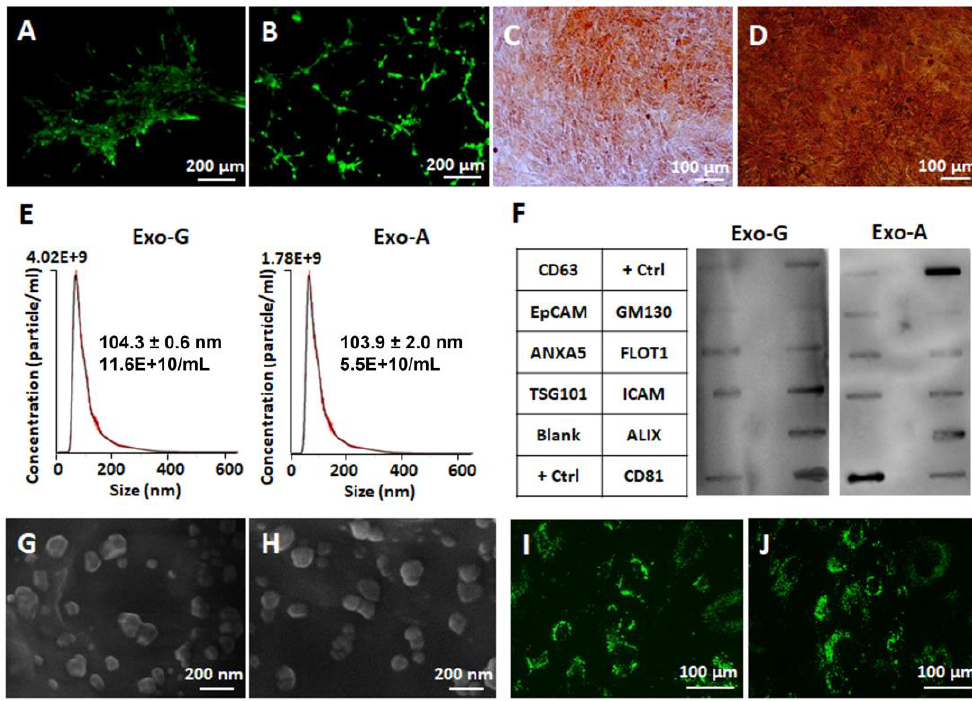
Figure 1. Characterization of rabbit dental pulp stem cells (DPSCs) and DPSC-derived exosomes (DPSC-Exos). ( A , B ) Tube formation as a marker of angiogenesis from DPSCs cultured in a regular medium ( A ) or angiogenic induction medium for 10 days ( B ). ( C , D ) Alizarin Red S staining as a marker of osteogenesis in osteogenic induction medium at 10 ( C ) and 20 ( D ) days. Exosomes were isolated from DPSCs cultured under a growth (Exo-G) or angiogenic differentiation condition (Exo-A). ( E ) Average size and concentration of Exo-G and Exo-A via Nanoparticle Tracking Analyzer (NTA). Red error bars indicate ± standard error of the mean ( n = 3) ( F ) Exosome antibody array having eight positive markers (CD63, EpCAM: epithelial cell adhesion molecule, ANXA5: annexin A5, TSG101: tumor susceptibility gene 101, FLOT1: flotillin-1, ICAM: intercellular adhesion molecule 1, ALIX: programmed cell death 6 interacting protein, and CD81) and four controls including cis-golgi matrix protein (GM130) as a negative marker for cellular contamination during exosome isolation, two positive controls (+ Ctrl), and a blank control (Blank). ( G – H ) Scanning electron microscopy (SEM) images of Exo-G ( G ) and Exo-A ( H ). ( I and J ) Cellular uptake of Exo-G ( I ) and Exo-A ( J ) using PKH67 green fluorescence.